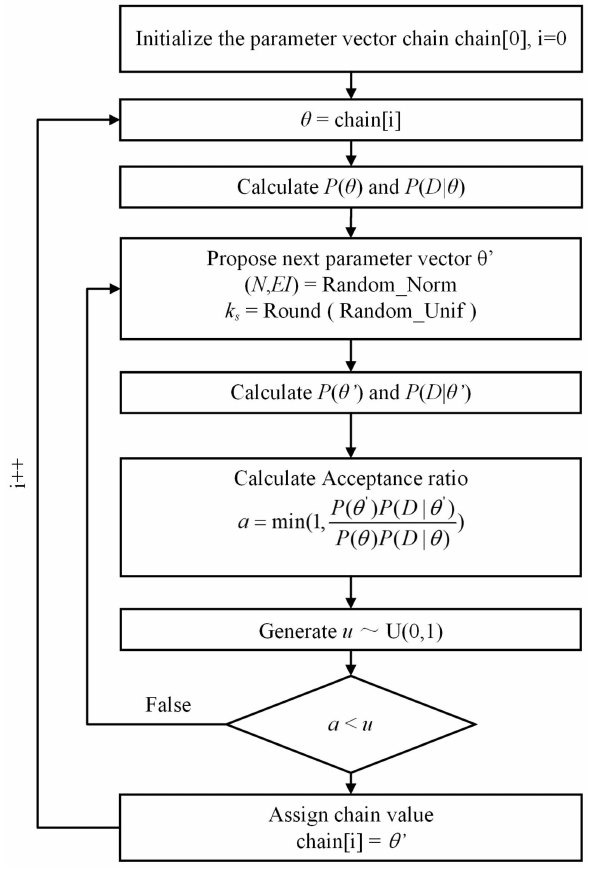
Figure 1. M-H algorithm for MCMC